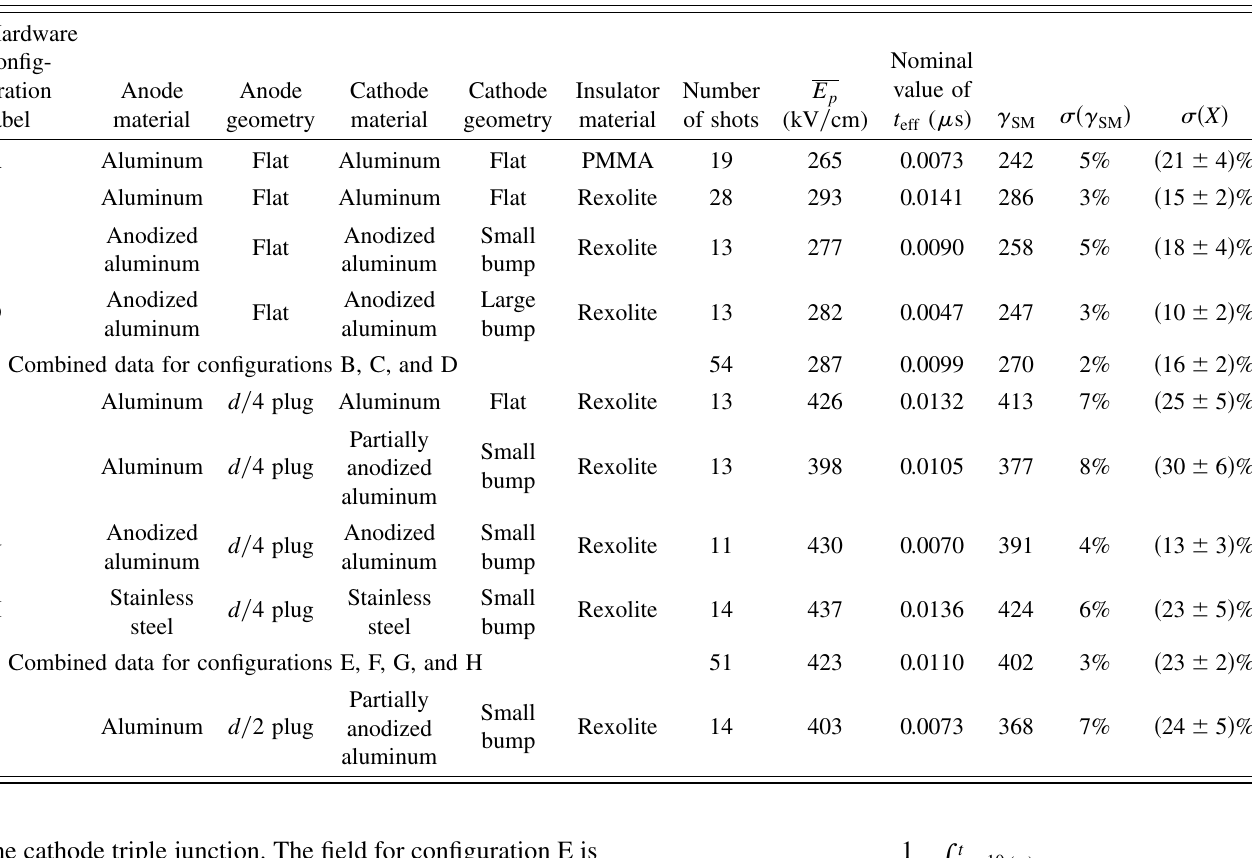
(cid:4) , and (cid:28) (cid:2) X (cid:4) , t (nominal), (cid:27) , (cid:28) (cid:2) (cid:27) p eff SM SM assume E is expressed in kV = cm , t in (cid:20) s , and d , C in cm. For all p SM eff